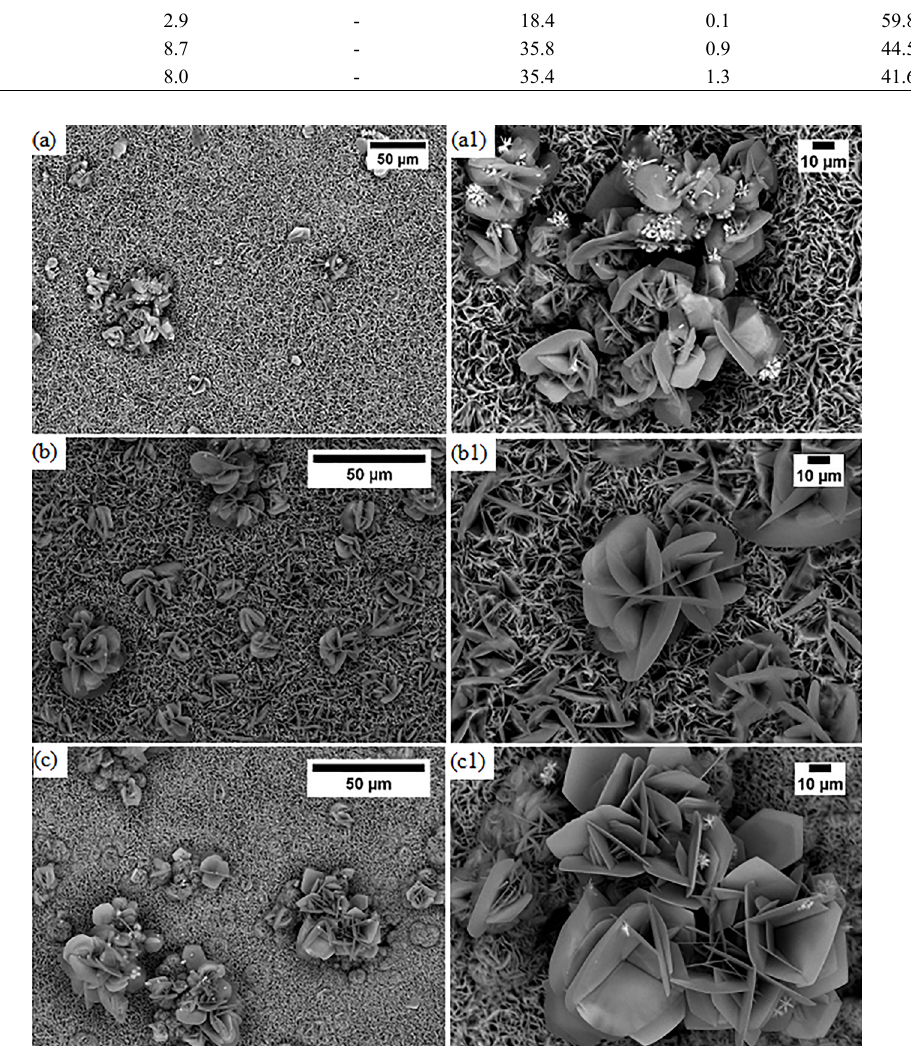
Figure 3. SEM images of aluminum alloy 5052 etched in 2M HCl solution after treatment with zinc nitrate - (a) 10 min; (b) 20min and (c)